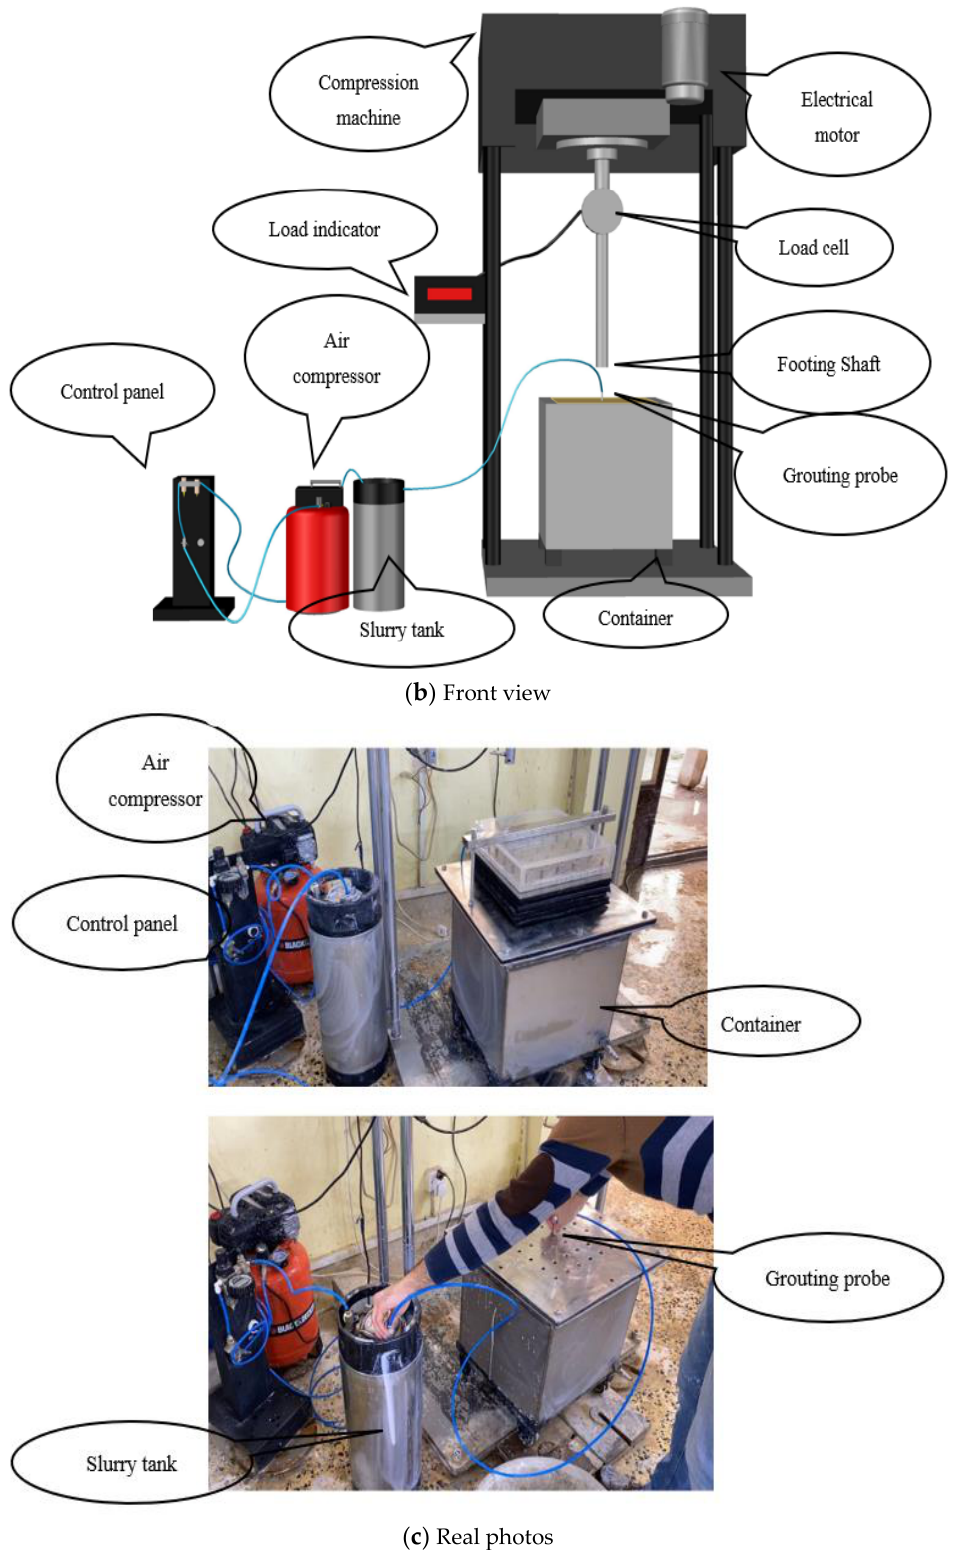
Figure 4. Grouting assembly.